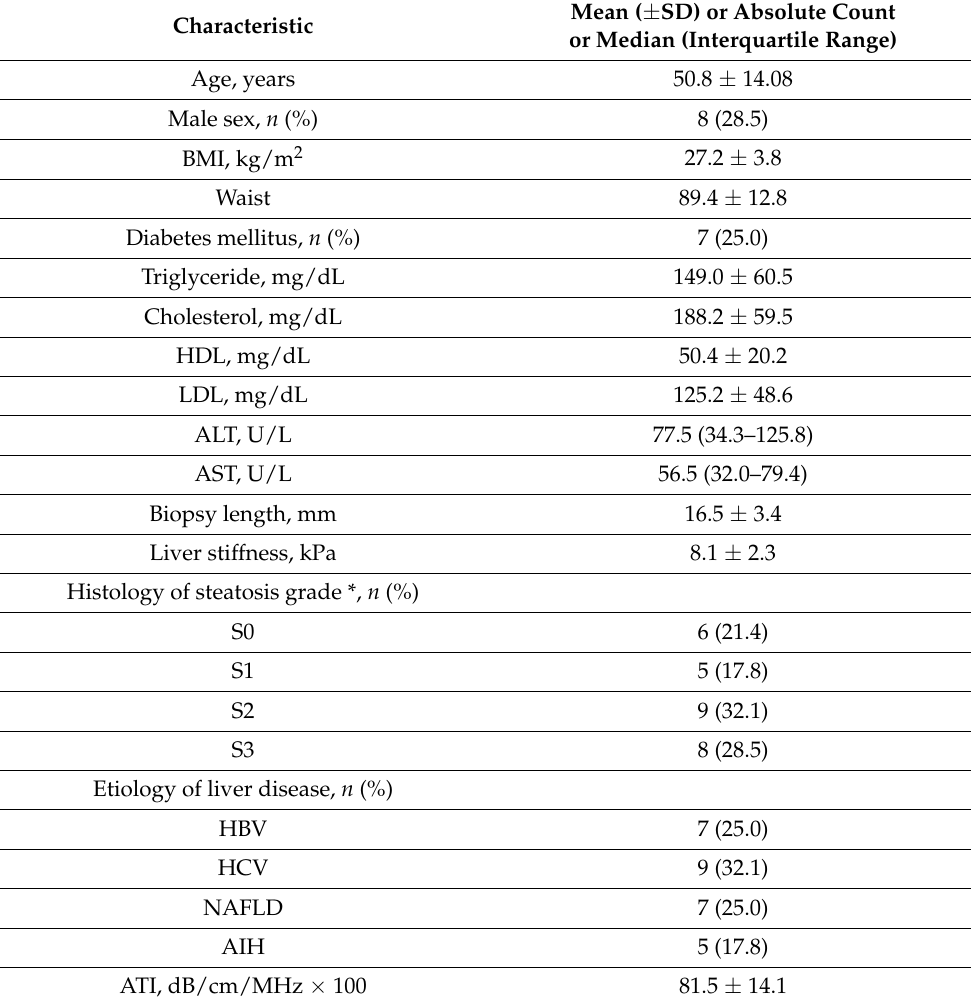
Table 1. Clinical characteristics of the patients ( n =